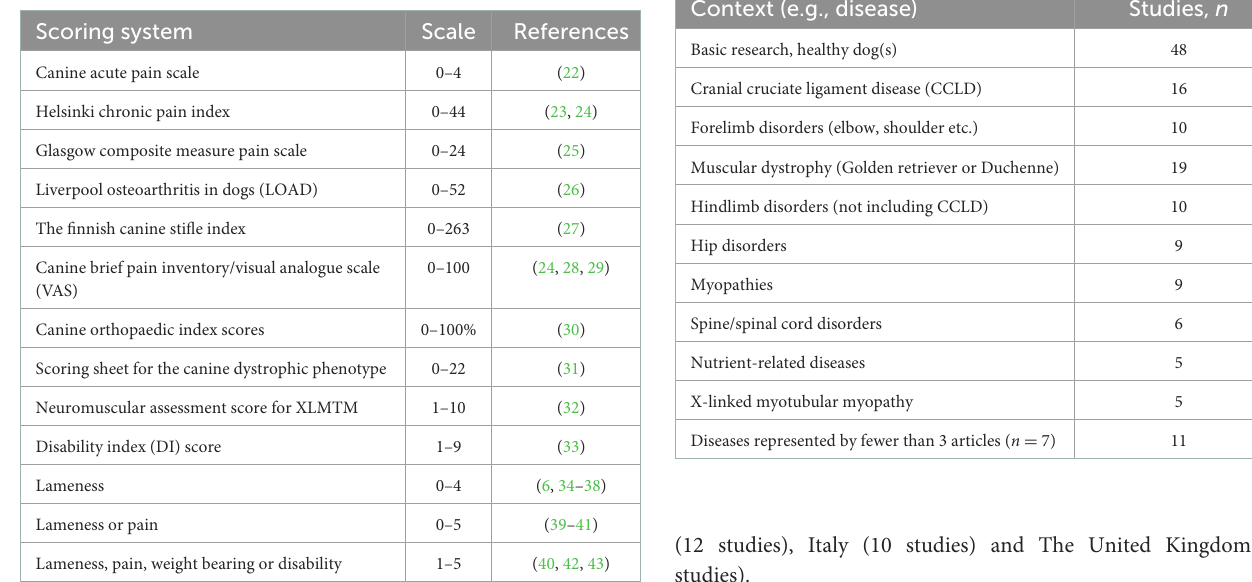
TABLE 3 The context areas in the included